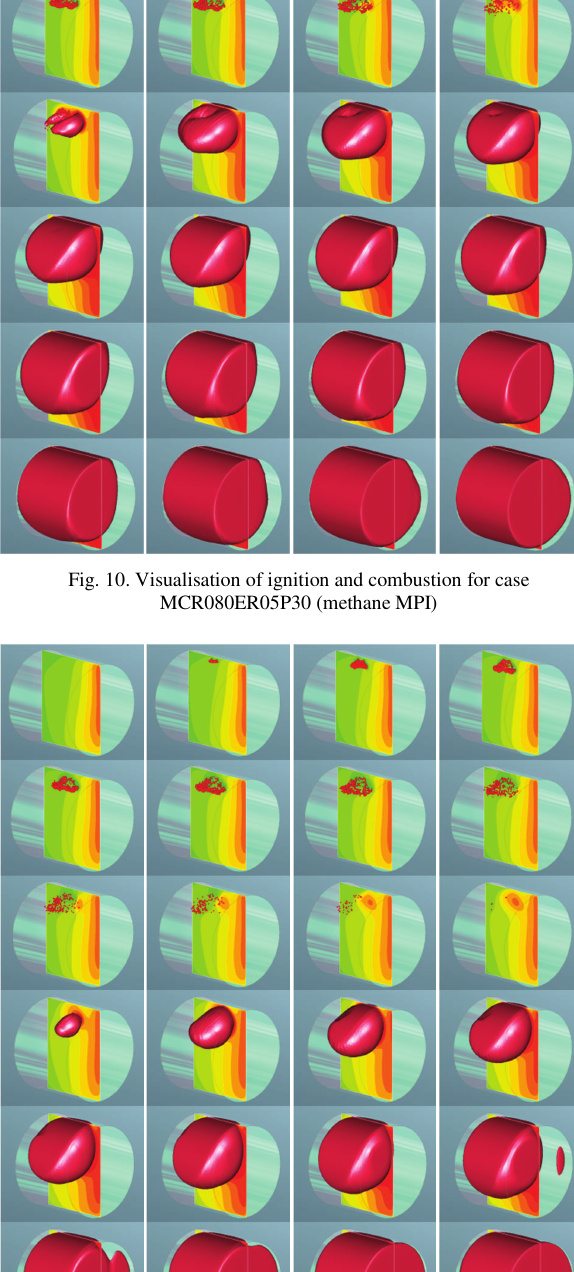
Table 8. Cases calculated with ϕ = 0.5 and CAI mode